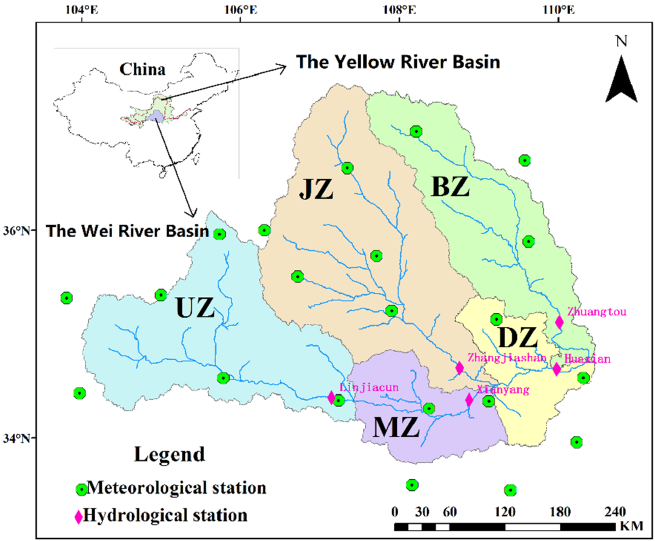
Figure 2. Map of the Wei River Basin and the five sub-zones. Table 1. Details of the five hydrological stations.